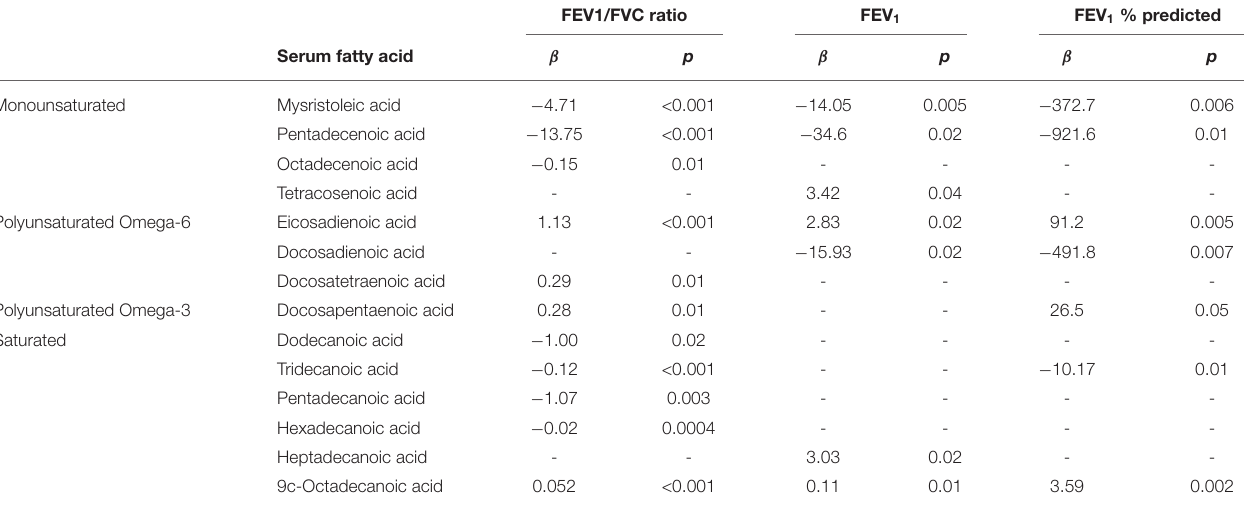
TABLE 4 | Significant associations between fatty acids and lung function outcomes in fully adjusted